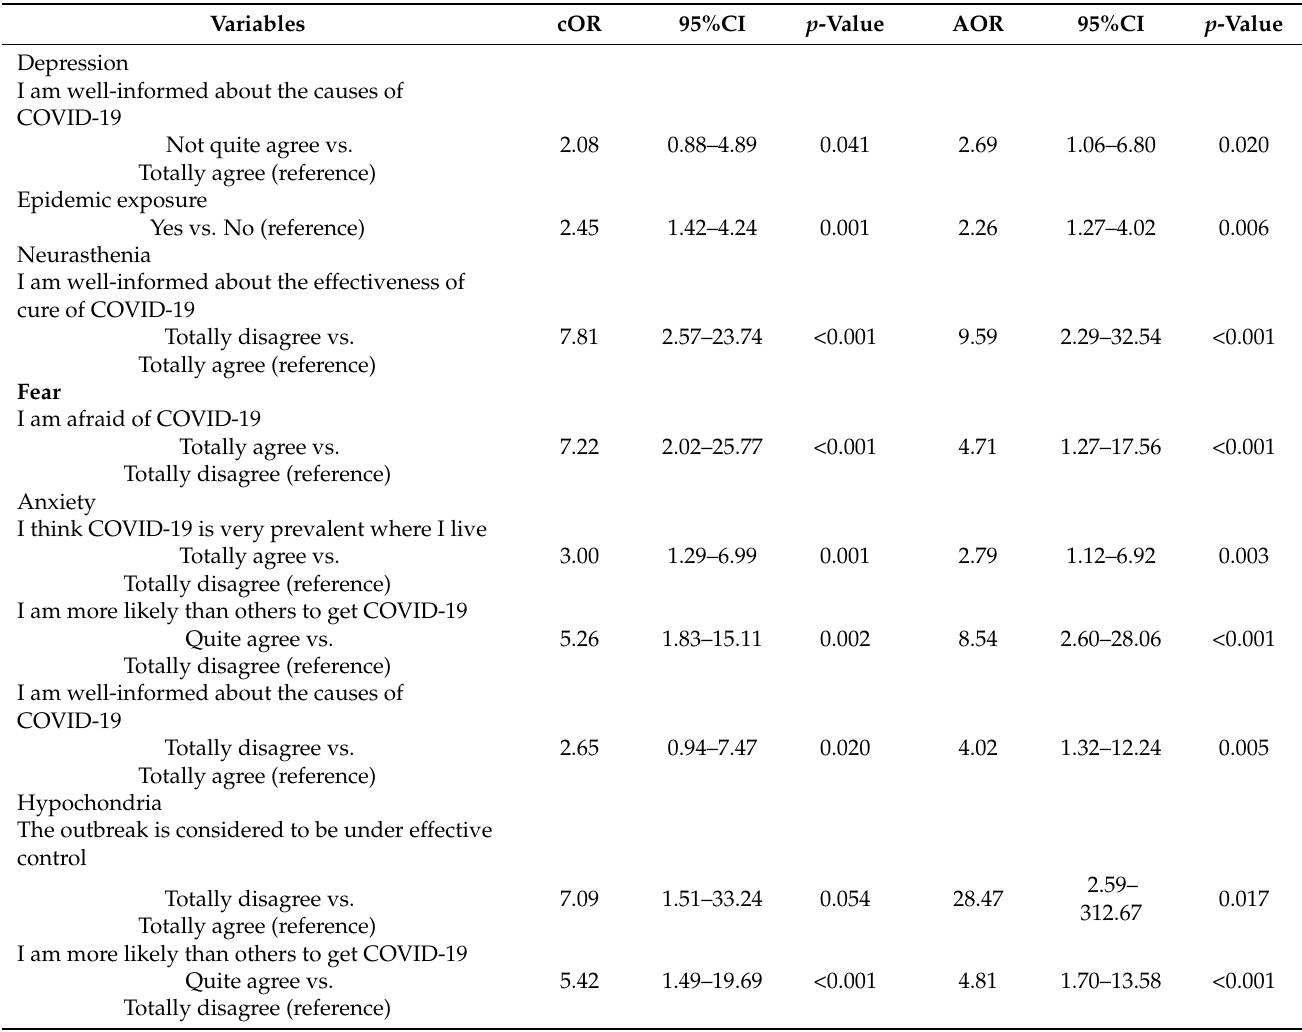
Table 5. Multivariate logistic regression analysis affecting the psychological status of MSM population during COVID-19 (n =